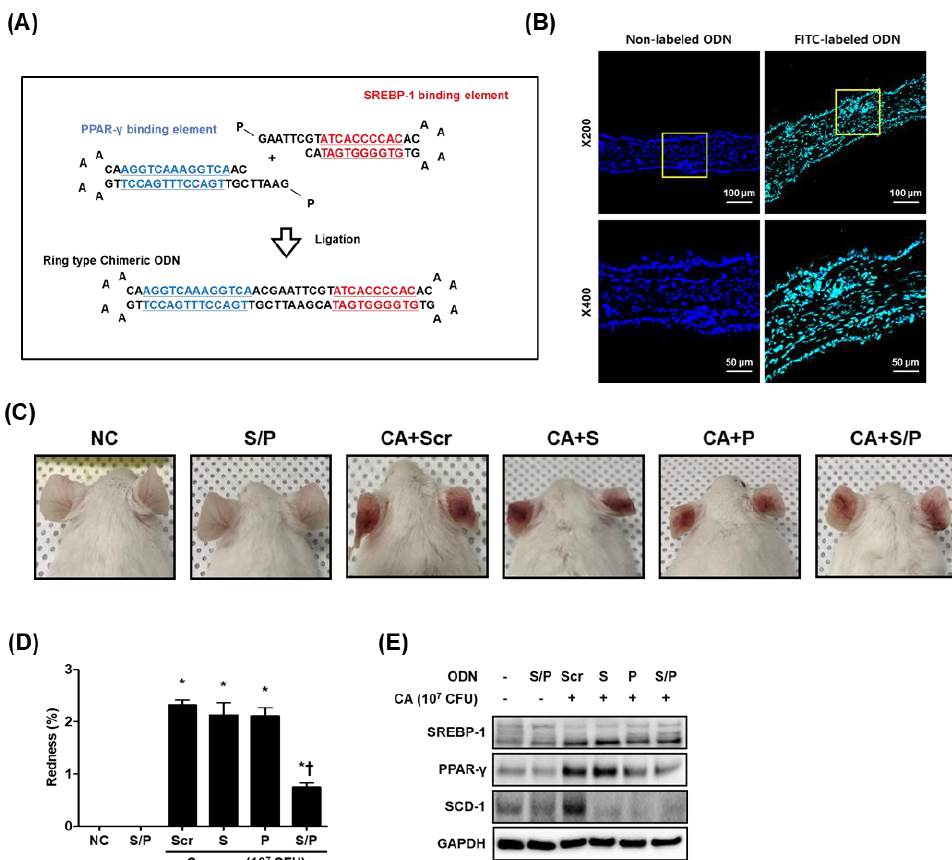
Figure 1. The SREBP/PPAR chimeric decoy ODN was effectively transferred in ear skin. ( A ) Structure of the synthetic SREBP/PPAR chimeric decoy ODN. ( B ) The transfer effectiveness of the SREBP/PPAR chimeric decoy ODN in ear skin (green). DAPI (blue)-stained nuclei. ( C ) Representative mouse ear skin lesion images. ( D ) The redness of the ear skin. ( E ) Single and chimeric decoy ODNs suppressed the protein expression of SREBP-1, PPAR- γ , and SCD-1. * p < 0.05 compared with the NC. † p < 0.05 compared with the